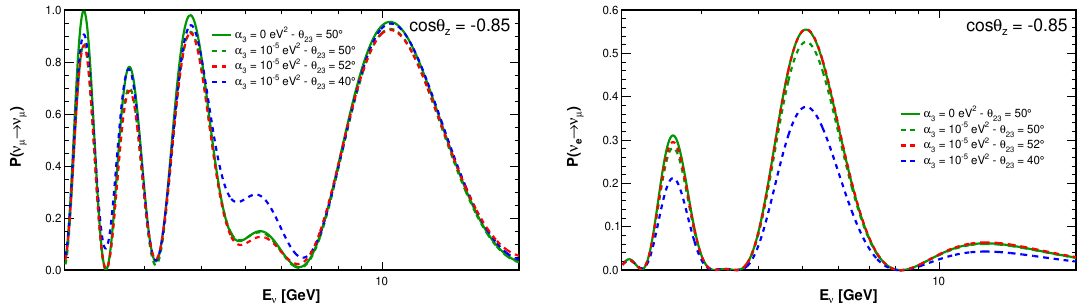
Figure 3. Muon neutrino survival (left) and electron neutrino oscillation to muon neutrino (right) probabilities as a function of energy at a cosine of the zenith angle cos θ z = − 0 . 85 assuming NO. Four cases are shown: α 3 = 0 with θ 23 = 50 ◦ (solid green), α 3 = 10 − 5 eV 2 with the same value of θ 23 (dashed green) and with two different values: θ 23 = 52 ◦ (dashed red) and θ 23 = 40 ◦ (dashed blue).